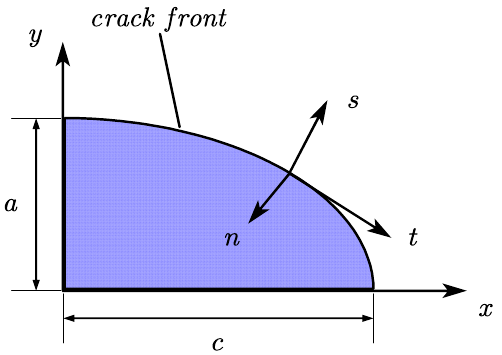
Figure 3. Local coordinate system of the quarter-elliptic crack front.